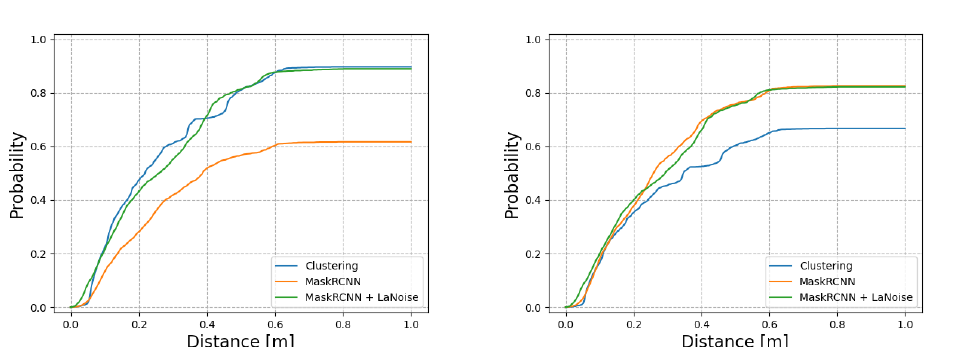
Figure 9. The performance of the detectors in poor weather conditions. ( Left ): The probabil- ity of there existing a car in the ground-truth labels within a certain distance of a detection. Mask R-CNN + LaNoise and the clustering method perform well, while the Mask R-CNN on its own suffers during the poor weather. ( Right ): The probability of a car detection being made within a certain distance of a ground-truth label. By this metric, both the neural networks perform well, while the clustering method struggles to make detections of cars close to ground-truth labels to the same